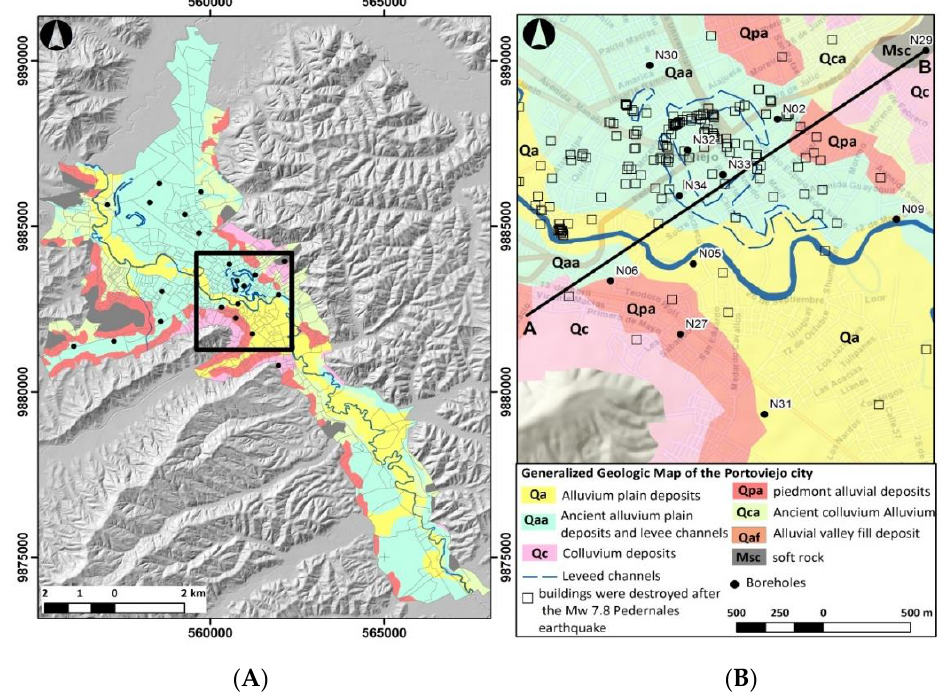
Figure 2. Local geological map of the city of Portoviejo ( A ), and location of the boreholes ( B ), adapted and modified from Cando-Jácome et al. [51].